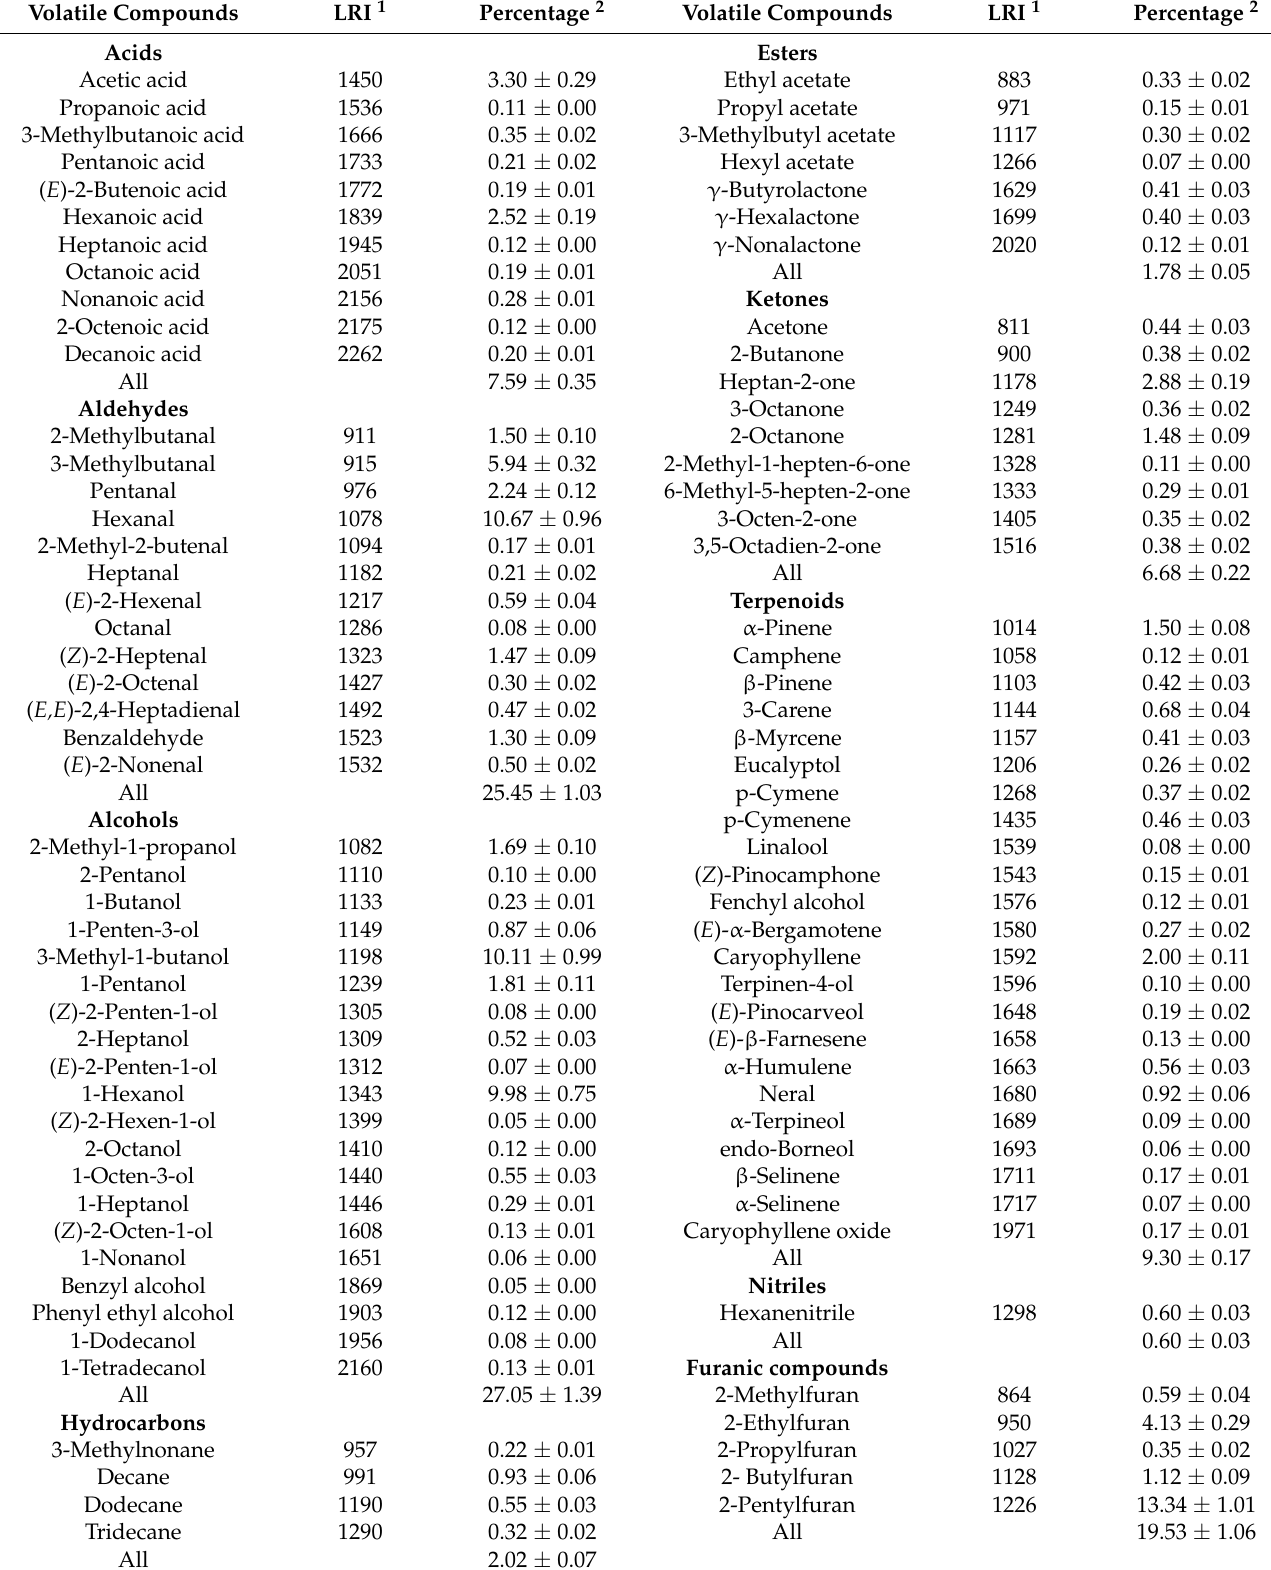
Table 8. Volatile fraction composition of hemp seed